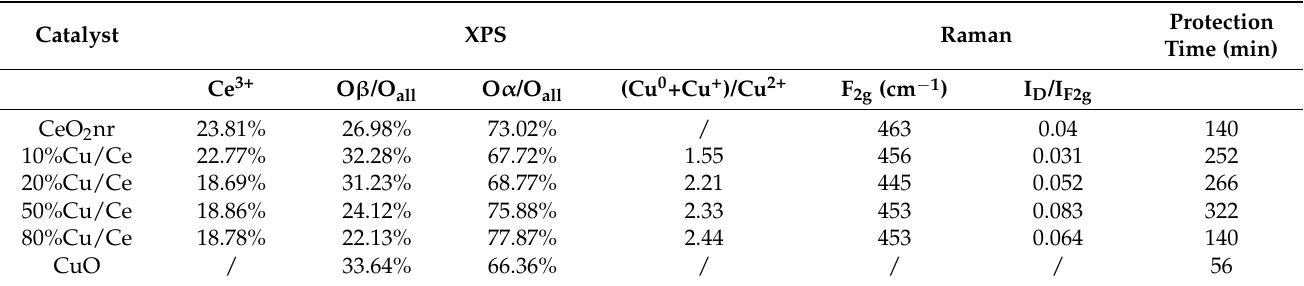
Table 4. XPS and Raman catalytic performance